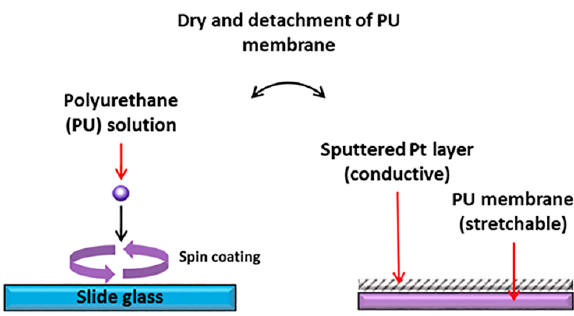
Figure 2. Fabrication process of the stretchable and conductive membrane.